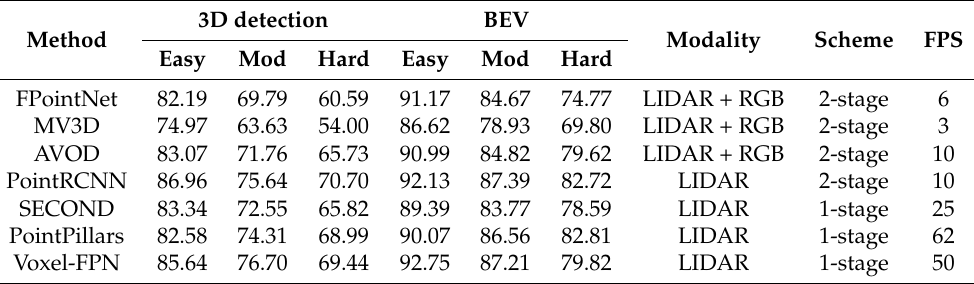
Table 1. 3D detection and Bird’s eye view detection performance of car (IoU(Intersection over Union) = 0.7): Average Precision (AP) (%) in the KITTI test